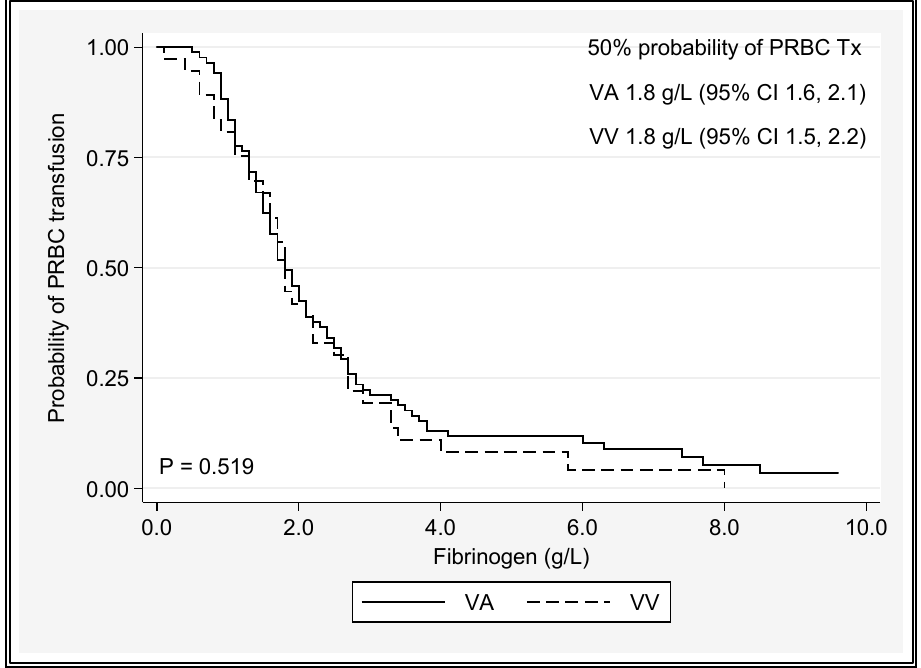
Figure 5. Fibrinogen level cut-off value associated with PRBC transfusion in VA and VV ECMO patients. Tx = transfusion.